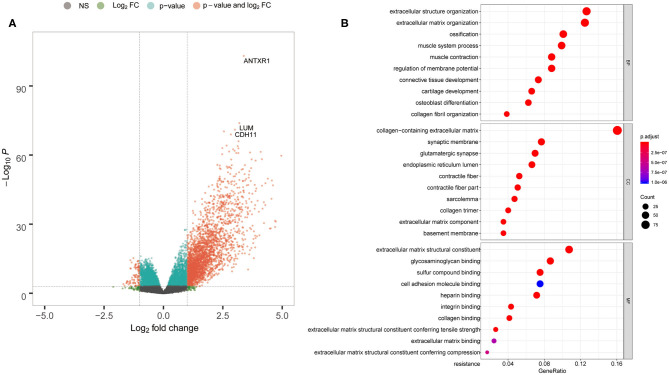
ANTXR1 involved in definite gene ontology (GO) terms in gastric cancer. (A) Volcano plot of the differentially expressed genes. (B) Results of BF (biological function), CC (cellular component), and MF (molecular function) terms analyzed.